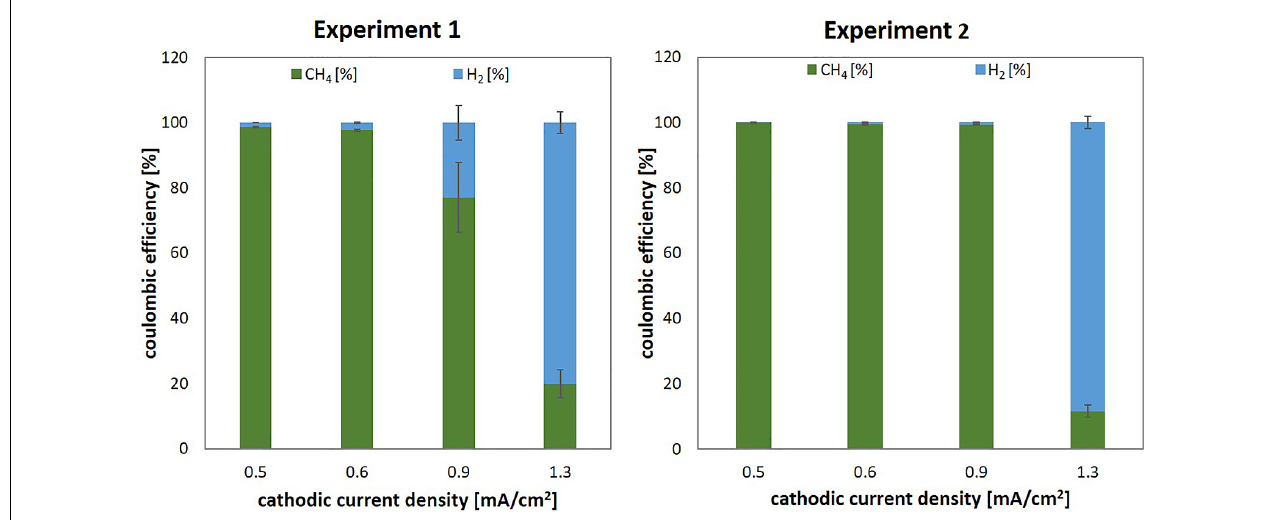
FIGURE 3 | Coulombic efficiencies achieved with the 3D printed cathodes of different surface areas under low cell density (Exp1, left) and high cell density conditions (Exp2, right). The given values are averages of 4–12 individual measurements taken after reaching steady state , with error bars displaying the standard deviation between individual